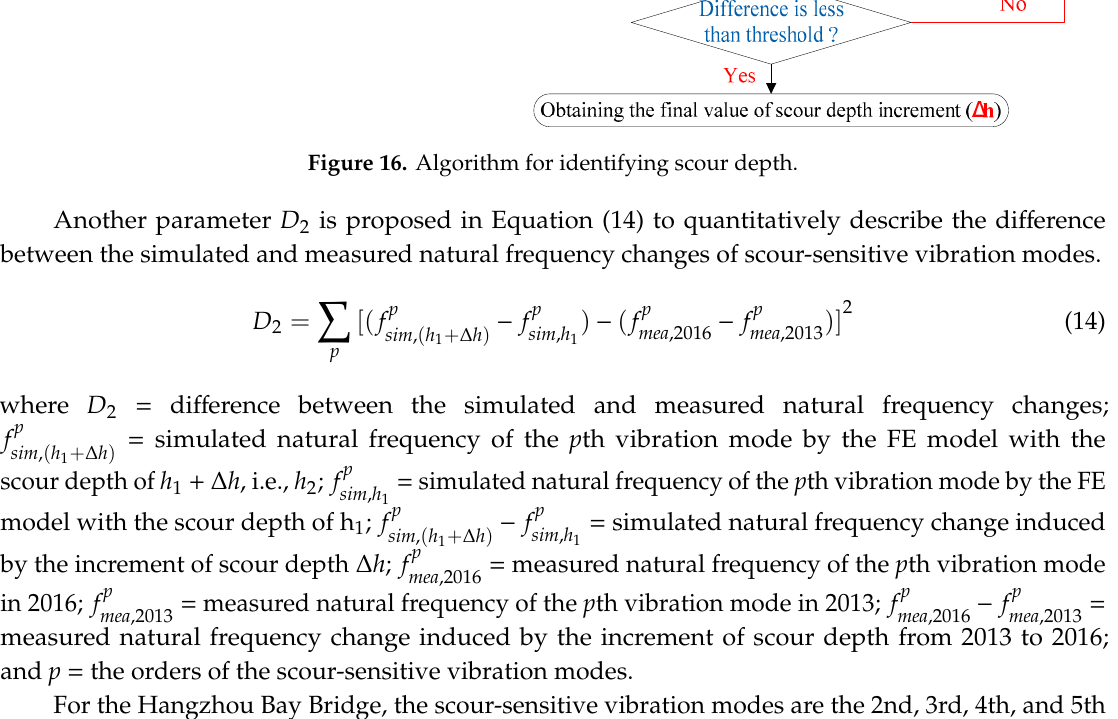
Table 8. Values of D 2 for different Δ h .